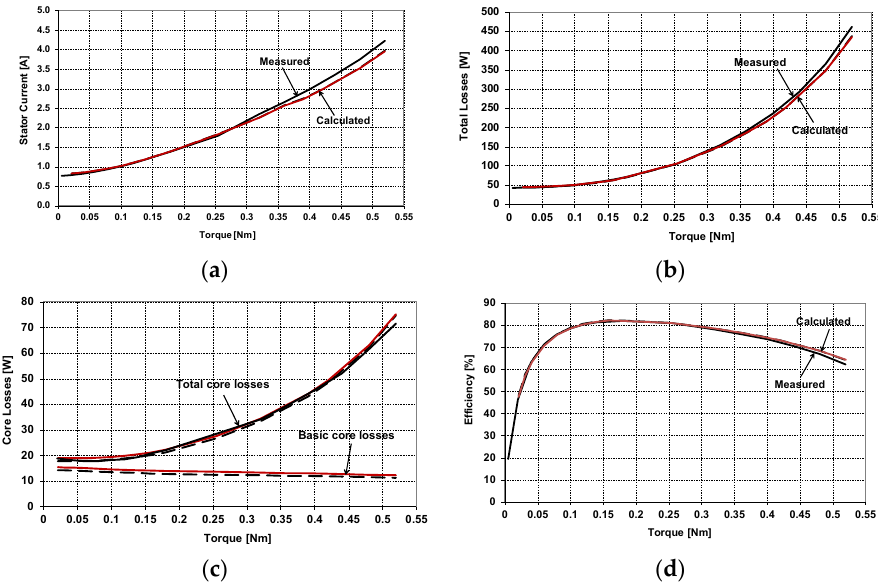
Figure 6. The measured at 300 Hz and calculated, stator current ( a ), total losses ( b ), core losses ( c ) and efficiency ( d ) for motor 1. Solid black curve—measured, dashed black curve—calculated for the characteristics measured for the specimen ring with a width of 10 mm, red one—calculated for the characteristics converted to the actual width of the teeth and yoke of the motor core.